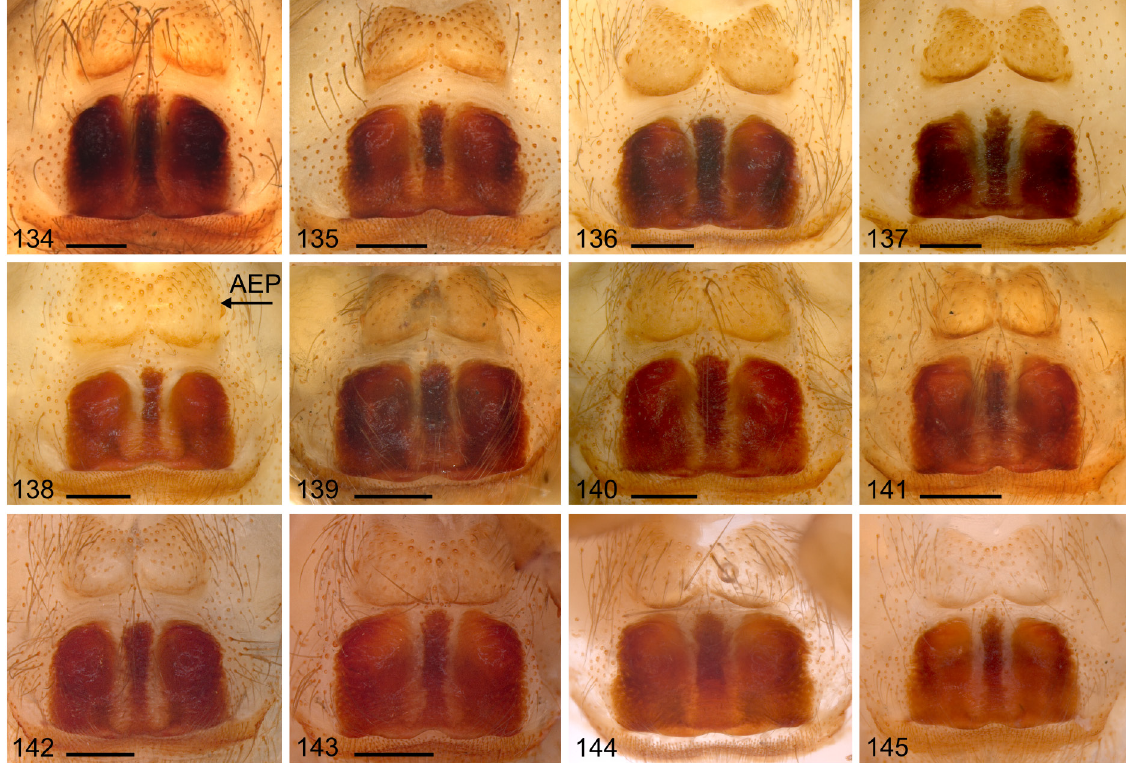
Figs 134–145. Artema transcaspica Spassky, 1934, intraspecific variation of epigynum. 134 . Uzbekistan, SE Bukhara (ZMMU). 135 . Uzbekistan, Ak-Mechat (ZMMU). 136–137 . Uzbekistan, SE Zarafshon (ZMMU). 138 . Turkmenistan, Badkhyz, Kushka (NHMW 13.677). 139–145 . Unspecified data: Tajikistan\Turkmenistan\Uzbekistan (ZIN type vials). Scale lines: 0.5